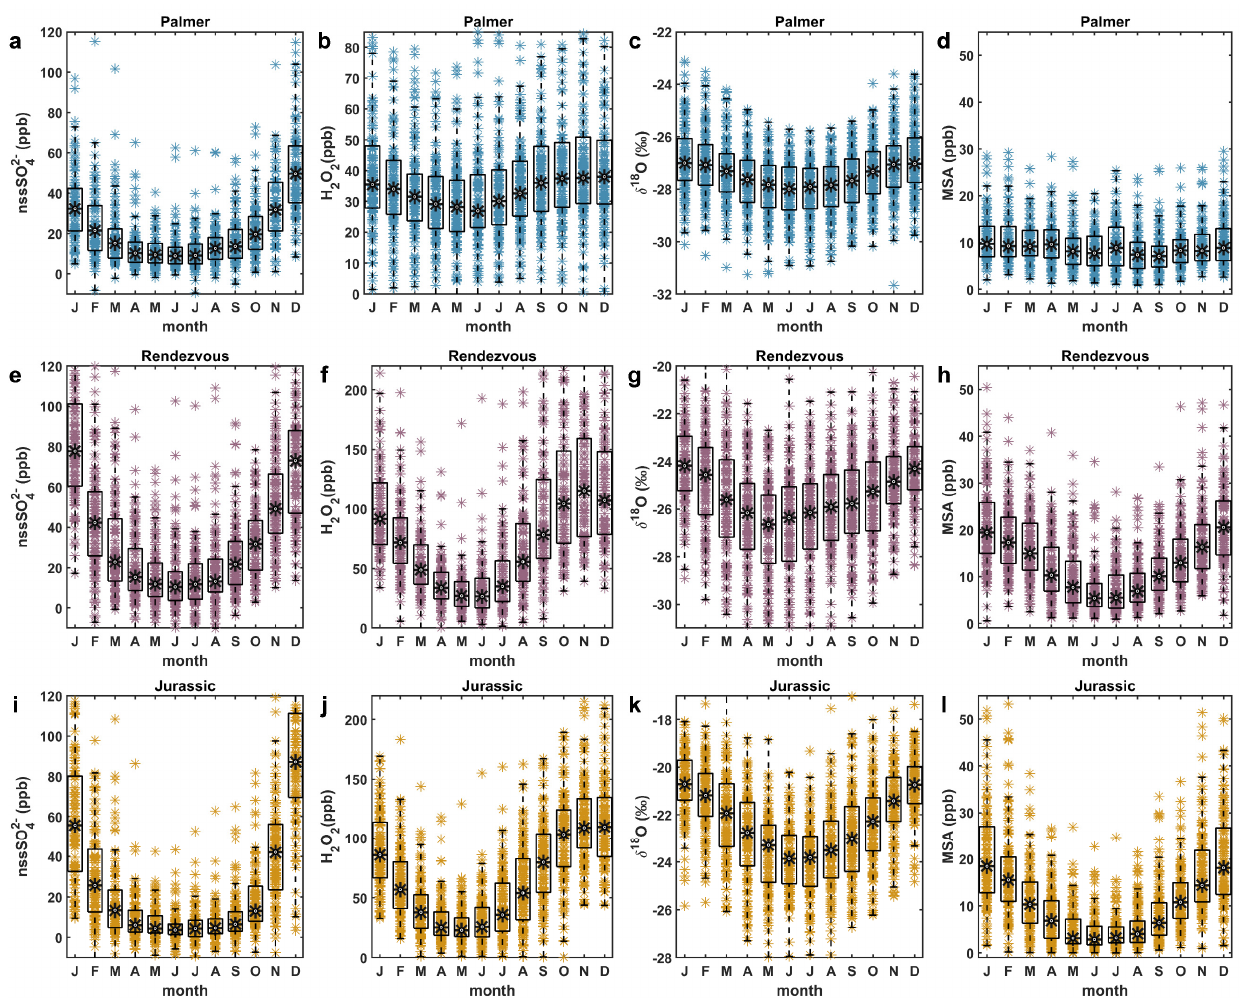
Figure 3. Seasonality of non-sea-salt sulfate [[nssSO 42 − ], (parts per billion, ppb)], hydrogen peroxide [H 2 O 2 , (ppb)], δ 18 O (‰), and methane sulfonic acid [MSA (ppb)] for the Palmer [top row ( a – d ), blue asterisks; 1874–2011 (the maximum overlapping period between the cores)], Rendezvous [middle row ( e – h ), purple asterisks; 1874–2011] and Jurassic [bottom row ( i – l ), yellow asterisks; 1874–2011] ice core sites. The monthly averages of chemical concentrations and isotope ratios are plotted against month. In the box plots the black asterisks shows the median values for all monthly values for each month, the box indicates the 25th and 75th percentiles, and the whiskers extend to the most extreme data points that are not classified as outliers. The panels are zoomed in to show the regions of interest clearly and do not display all values. Note the difference in scale on the y -axis between the sites for H 2 O 2 and δ 18 O.